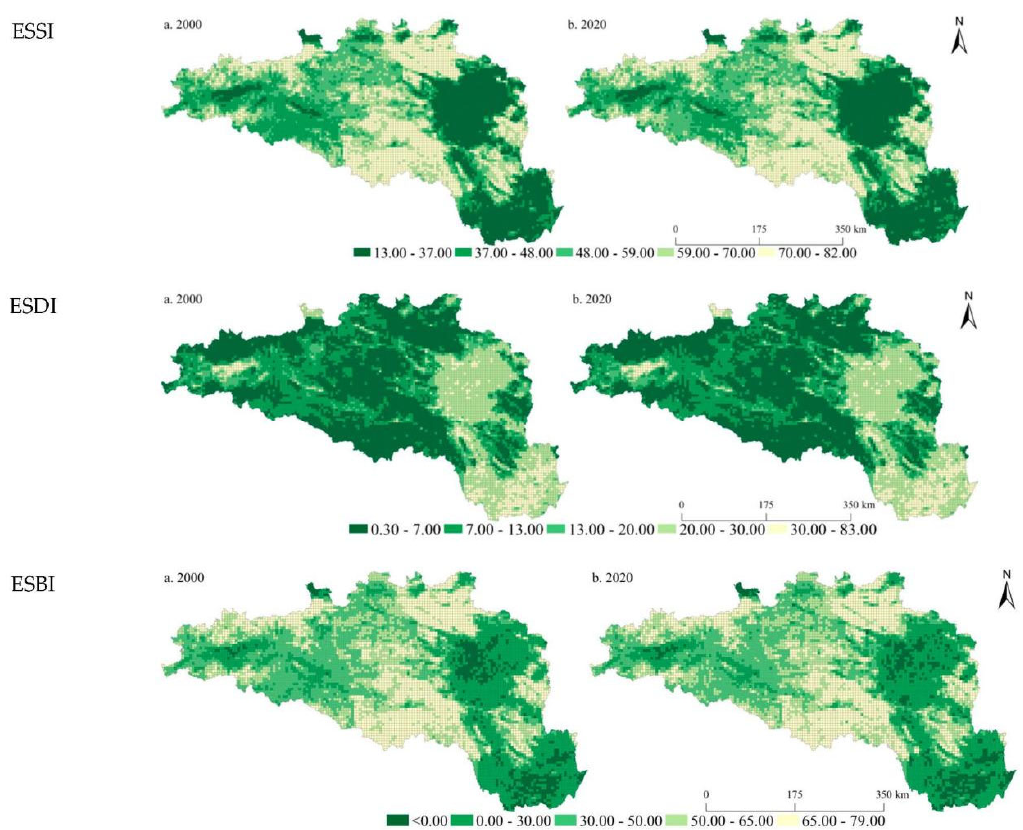
Figure 2. Spatial pattern of the ESSI, ESDI, and ESBI at the 5 km grid scale in the HREEB in China.